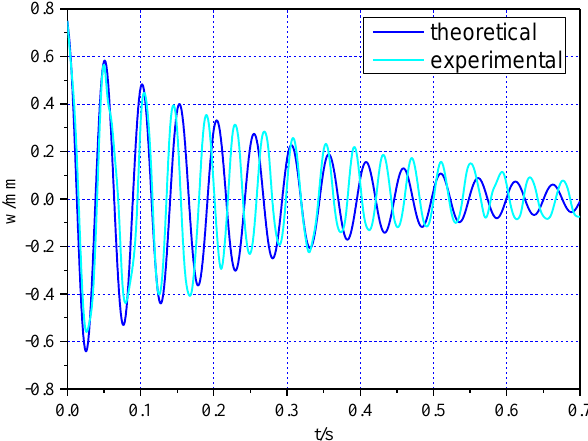
Figure 10. Comparison of two time-displacement curves under initial displacement 0.750 mm.